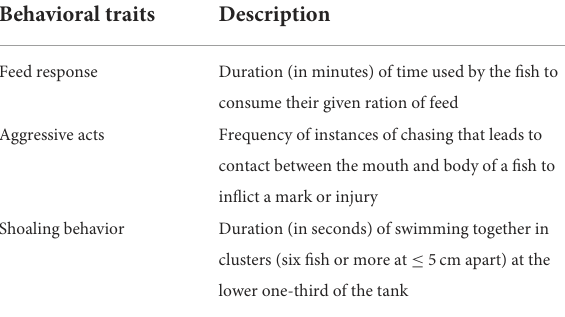
TABLE 1 Ethogram of the measured behavioral